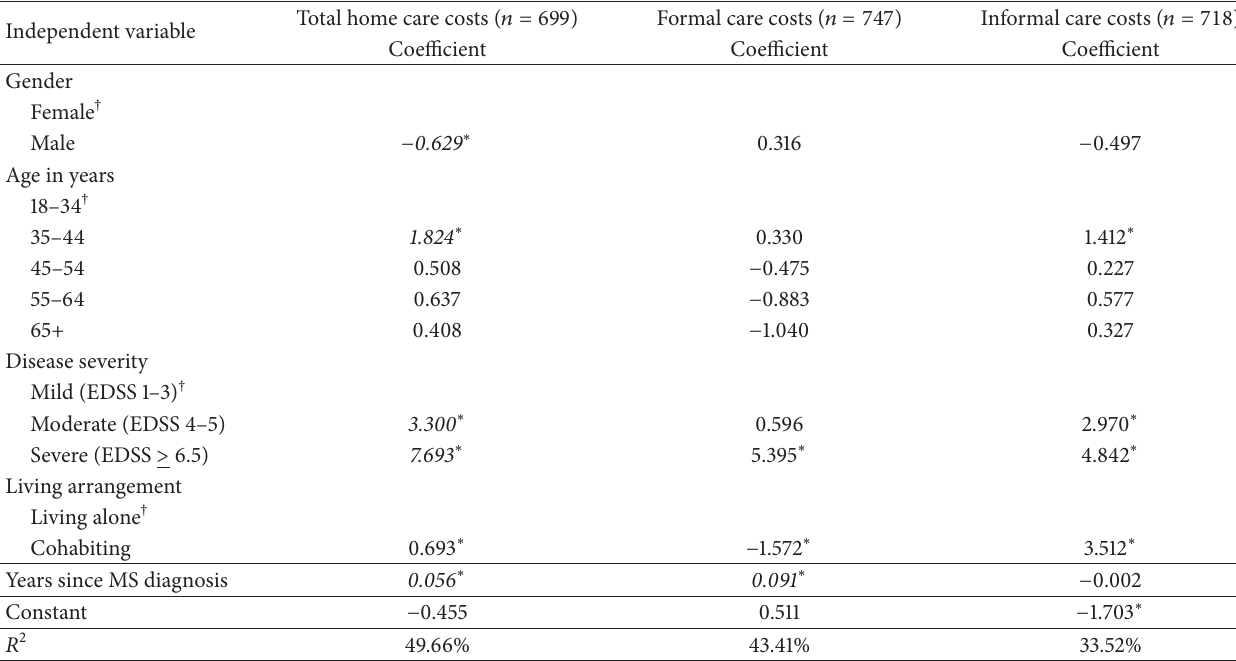
Table 5: Results of regression analyses for total home care costs, formal care costs, and informal care costs for persons with MS in